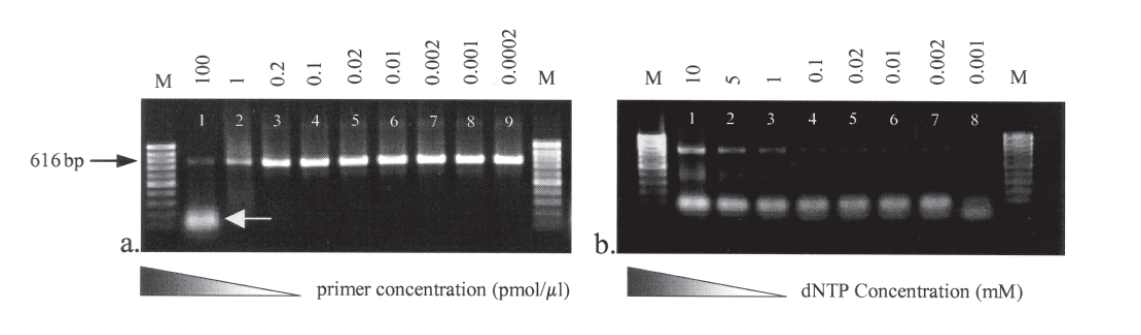
Fig. 1. Mg +2 concentrations (a) and amount of cDNA (b) as template in RT-PCR reactions. M, molecular size markers.